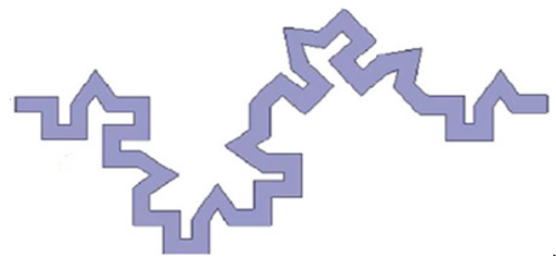
Figure 2. Proposed geometry of fractal after second iteration (n = 2).